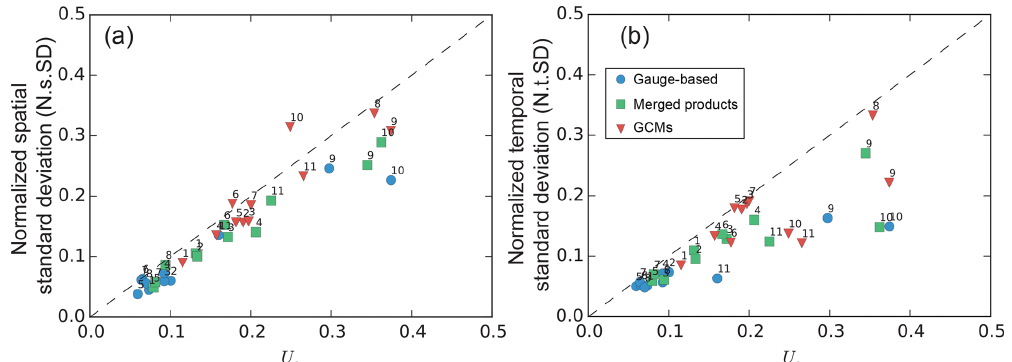
Figure 10. Relation of U e to the two classic metrics (a) normalized spatial standard deviation N.s.std and (b) normalized temporal standard deviation N.t.std. The two metrics are estimated with Eqs. (28) and (29) of the ensemble datasets in each of the three different precipitation groups.